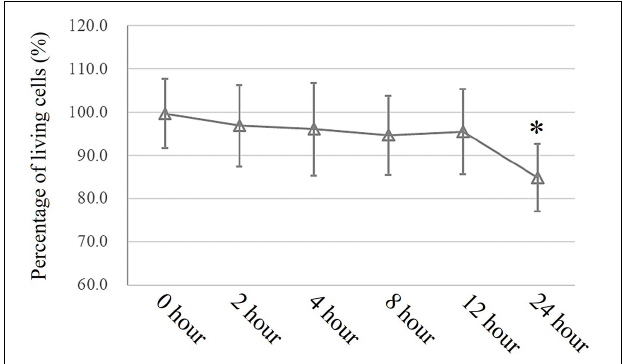
FIGURE 3 | MTT assay to assess cell viability. Cells propagated under normal atmospheric pressure were set as controls. Data are represented as the mean ± SD, n = 6, ∗ P < 0.05 vs. 0 h exposure in HSEACs.